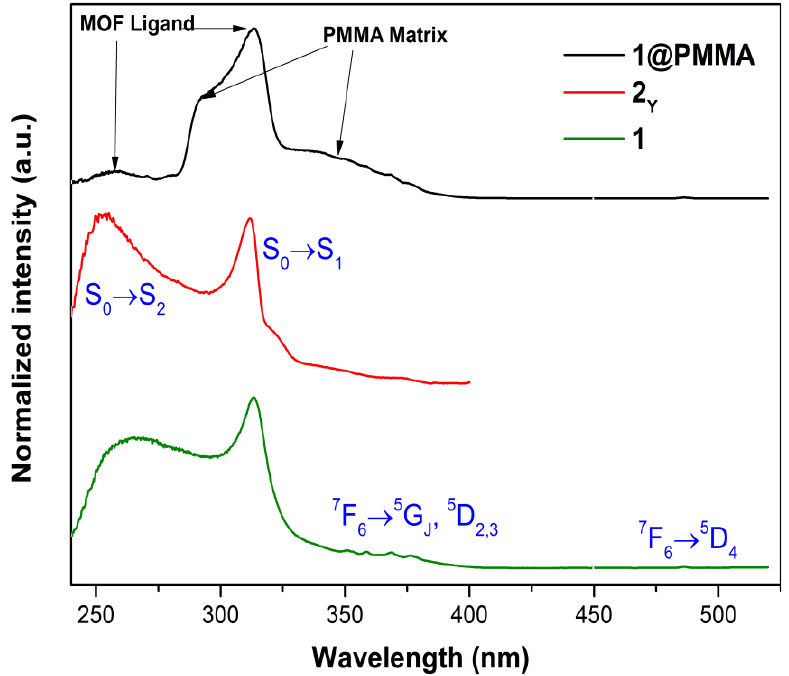
Figure 7. 12 K excitation spectra of 1@PMMA (black; λ Em . = 544 nm), the isotypical Y 3+ -based MOF 2 Y (red; λ Em . = 410 nm), and 1 pristine Tb 3+ MOF) (green; λ Em . = 544 nm).